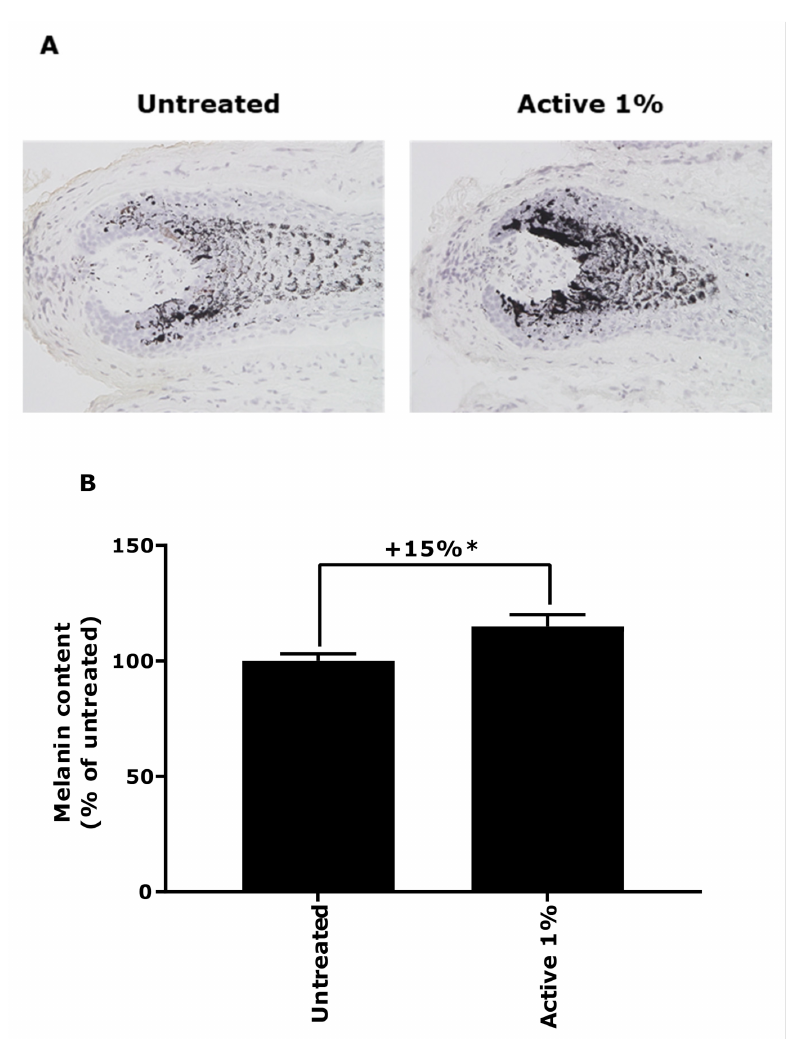
Figure 7. Evaluation of melanin content by Fontana-Masson staining of grey hair follicles treated with active ingredient at 1%. ( A ) Representative images. Magnification: 200 × . ( B ) Results expressed as percentage of untreated condition (data are presented as mean ± SEM). Statistical analysis was performed using a Student’s t -test, with * p <